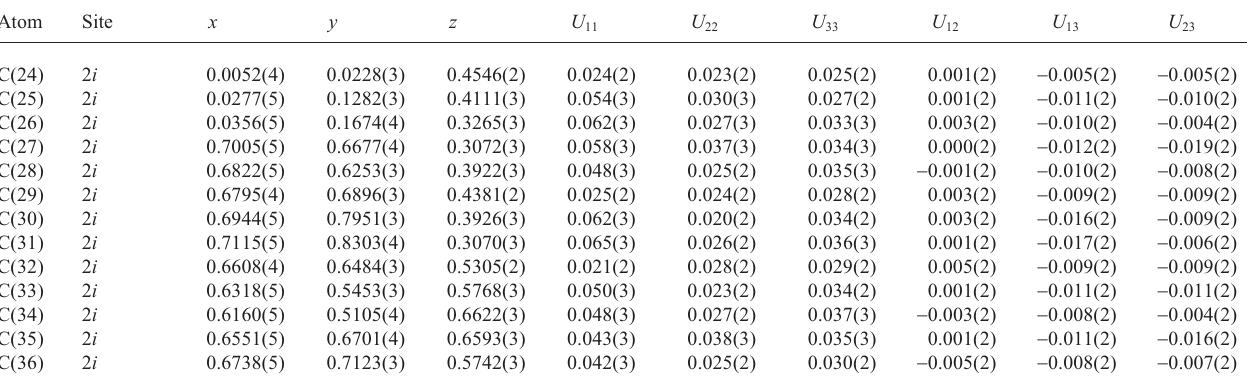
Table 3. Atomic coordinates and displacement parameters (in Å 2 )